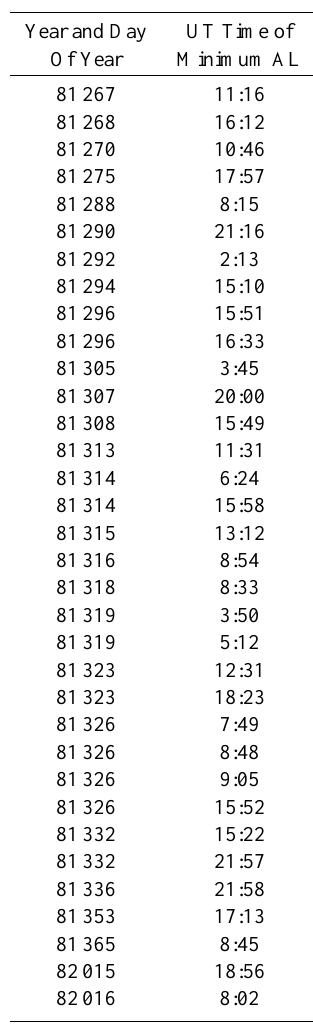
Table 2. List of events used in the study.